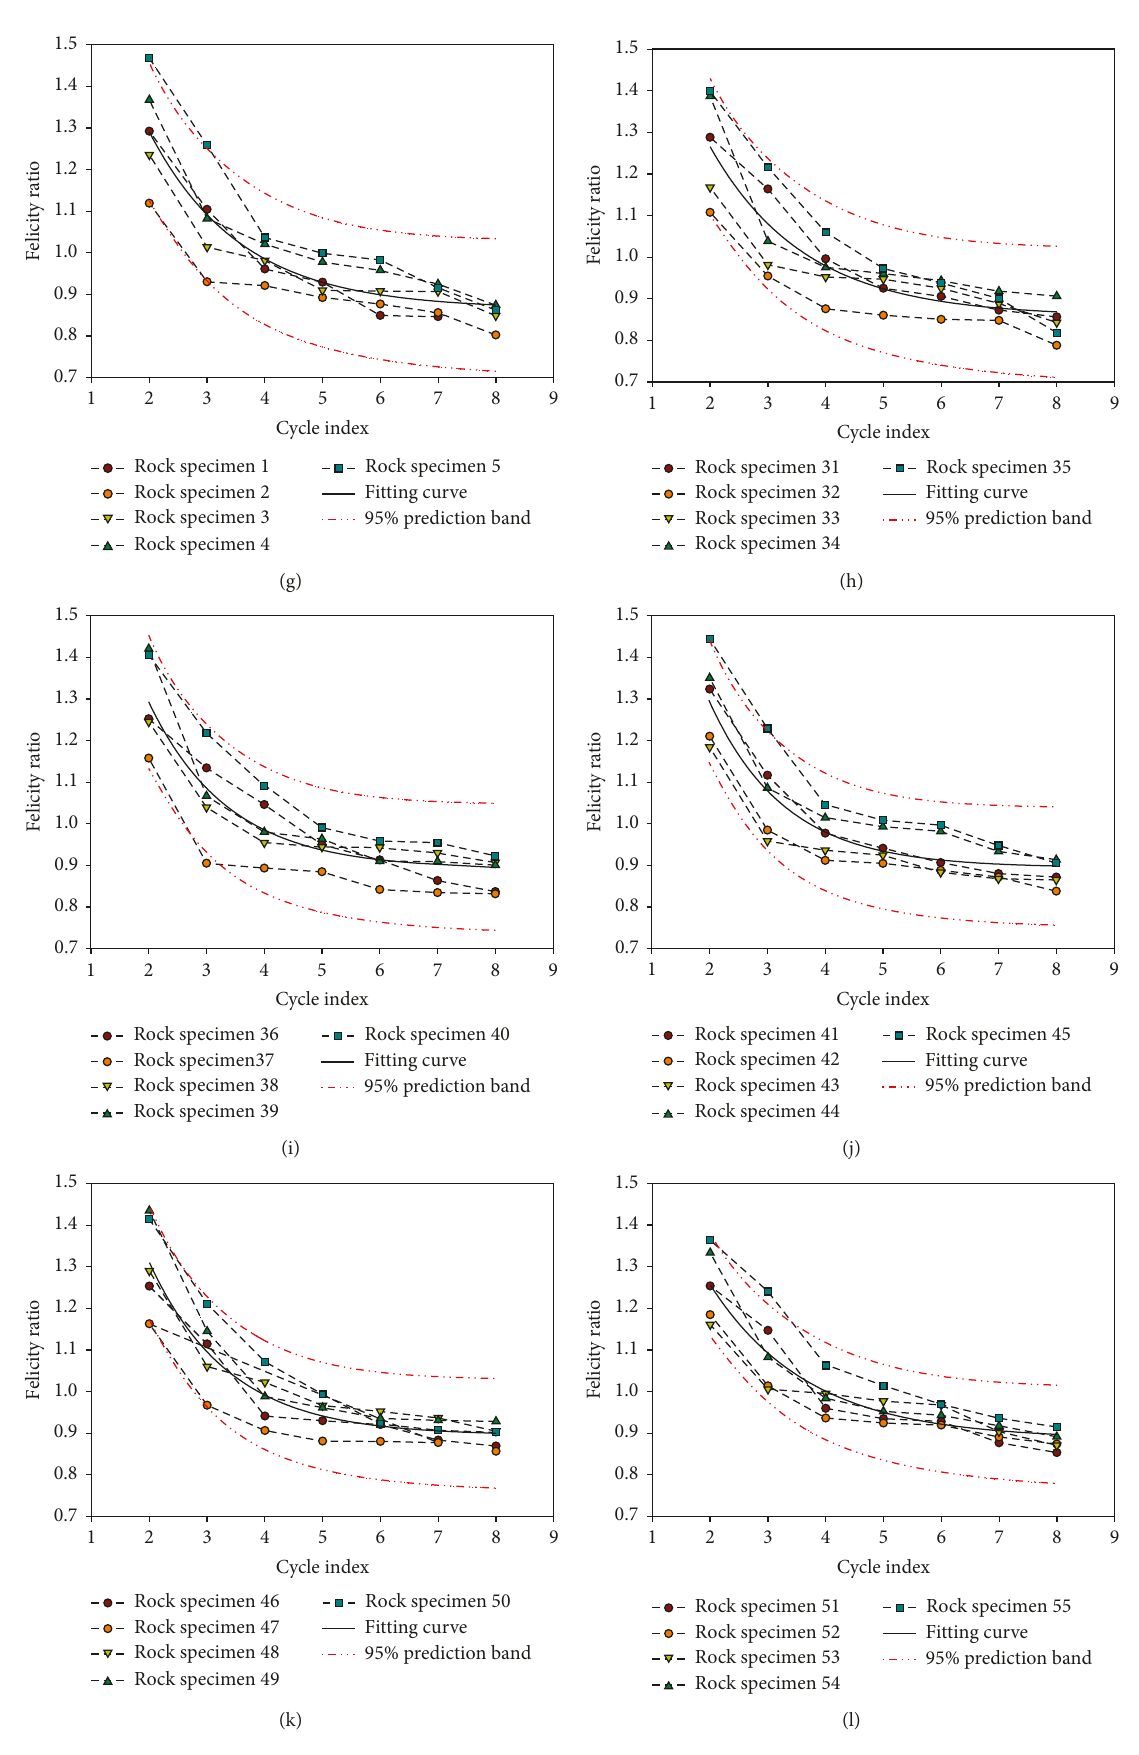
Figure 11: Variation of the rock Felicity ratio with the increasing loading